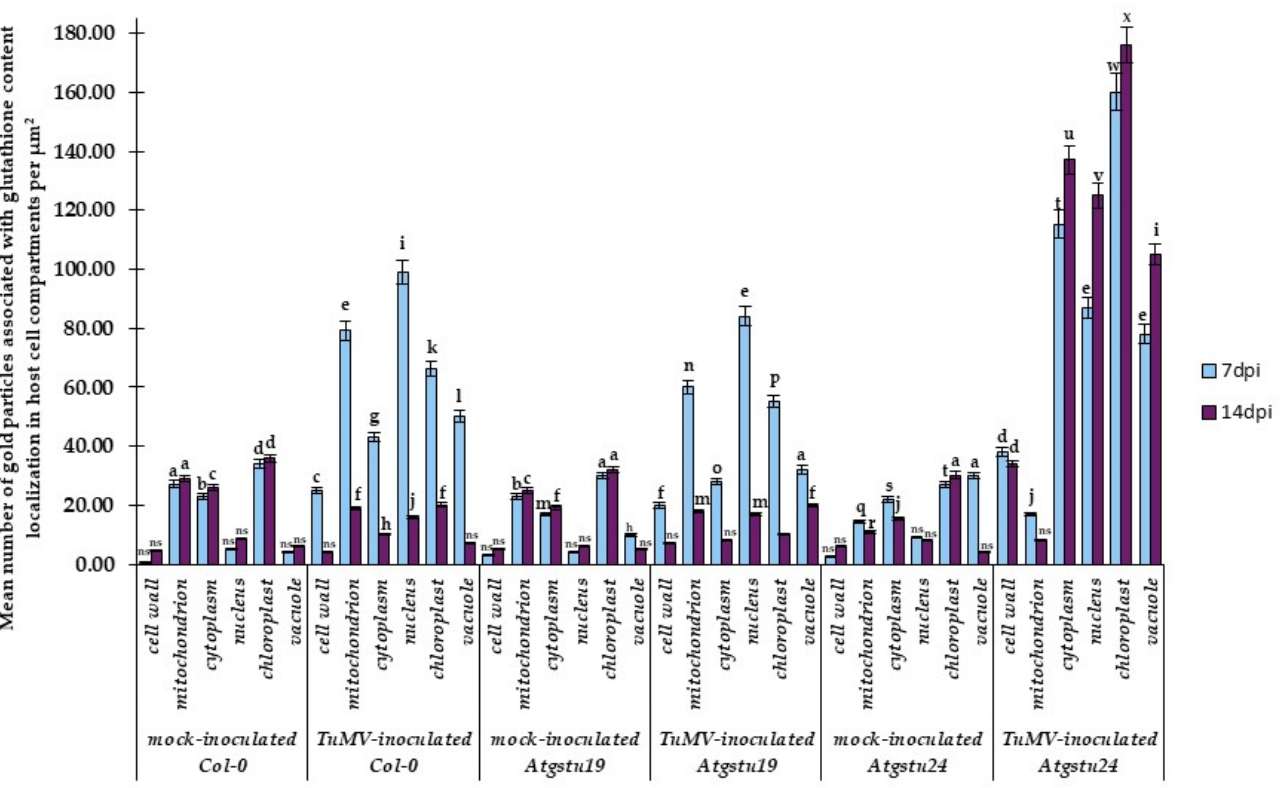
Figure 7. Quantitative immunogold labeling of glutathione content in mock- and TuMV-inoculated Col-0, Atgstu19 , and Atgstu24 leaves. The mean number of gold particles localized in specific com- partments per µ m2 at 7 and 14 dpi in mock- and virus-inoculated leaves is presented. Immunogold localization was validated using ANOVA. The mean values were calculated at p < 0.05 with post hoc Tukey’s HSD test. Statistically significant values are indicated by letters above the bars. Nonsignificant values are indicated as ns.